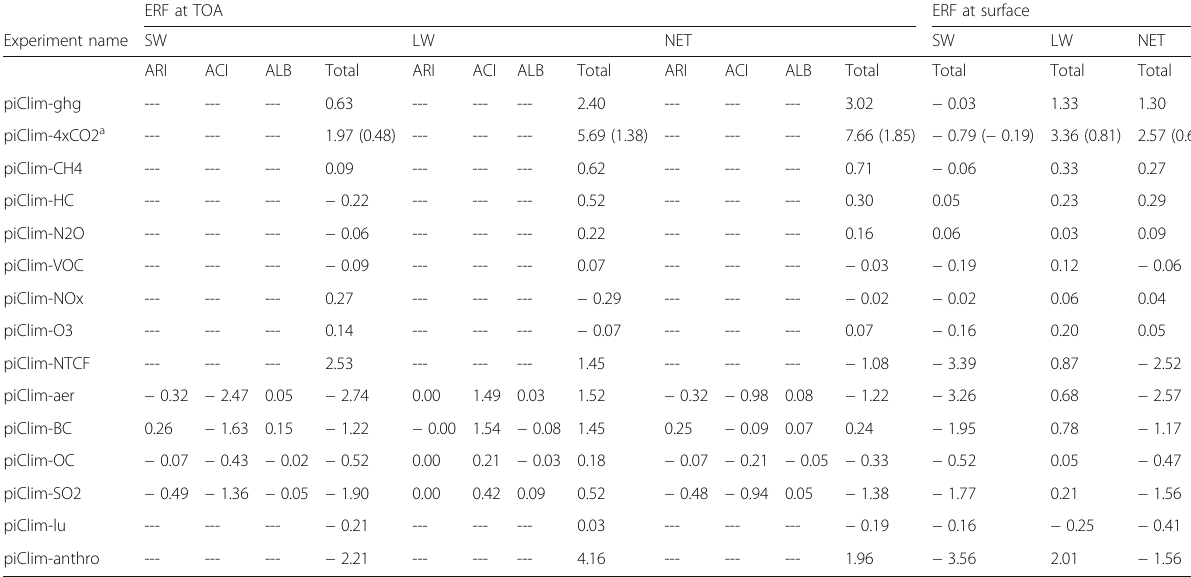
Table 2 Global annual mean effective radiative forcings of each experiment ERF at TOA ERF at